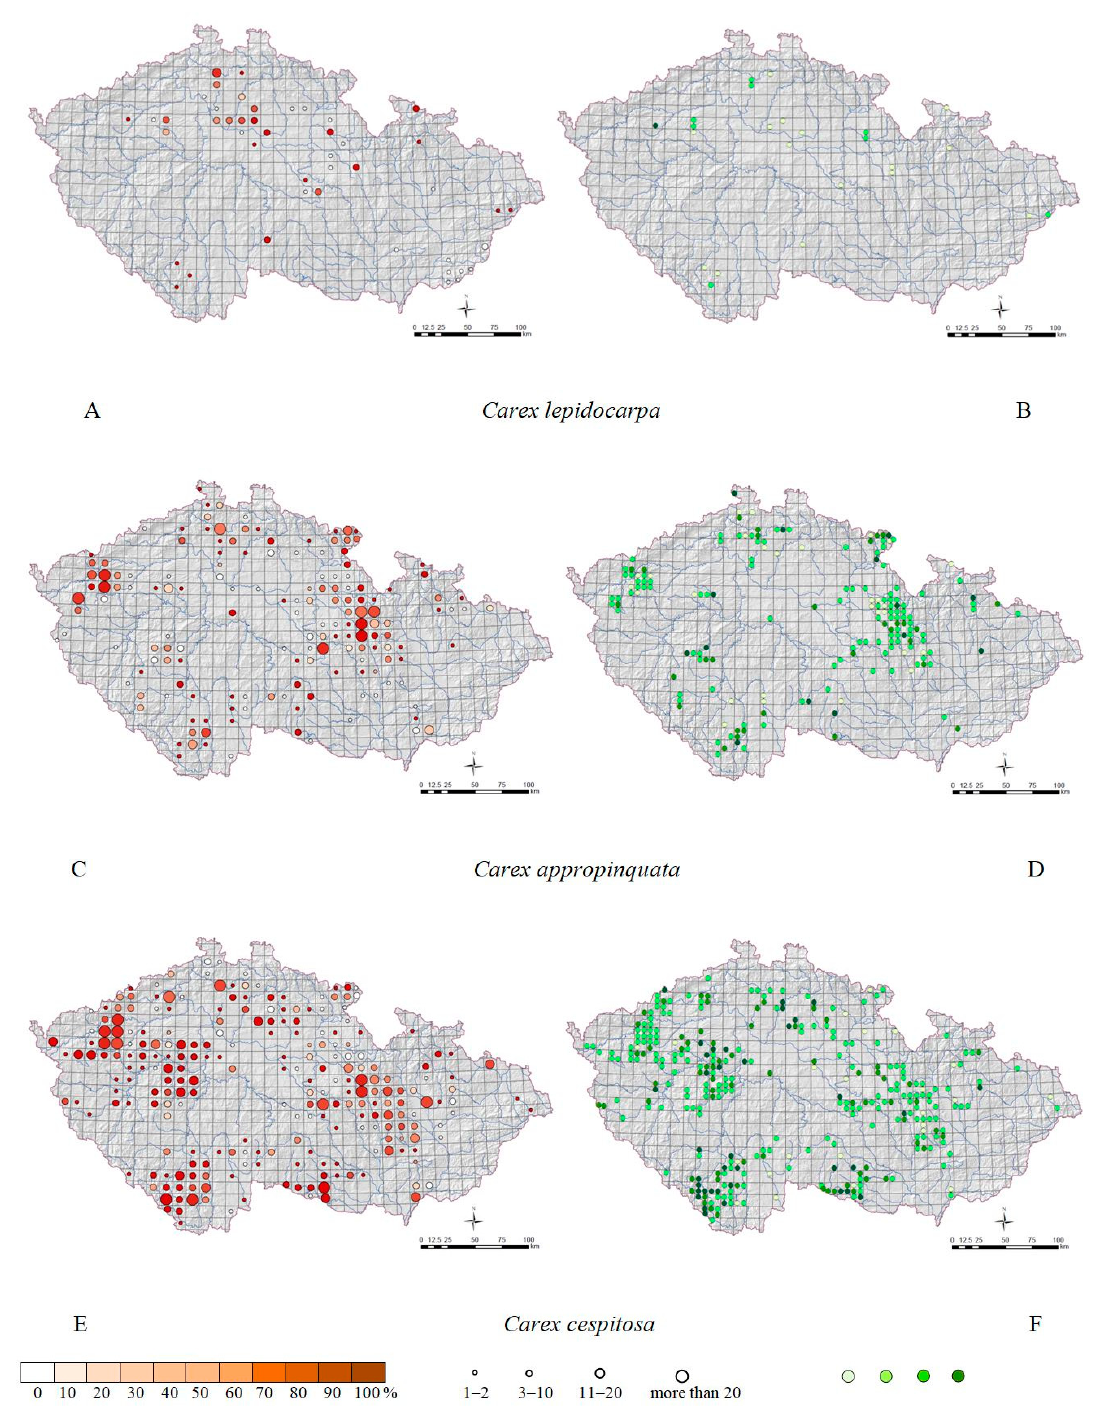
Figure 1. Maps ( A , C , E ): number of occurrences (dot size) and knowledge level of habitat quality (brownish colour); empty circle (0 %) = occurrence of the species outside the habitat. Maps ( B , D , F ): habitat quality (1–4); the darker the green colour, the lower the values of quality are. Grid of 10 × 10